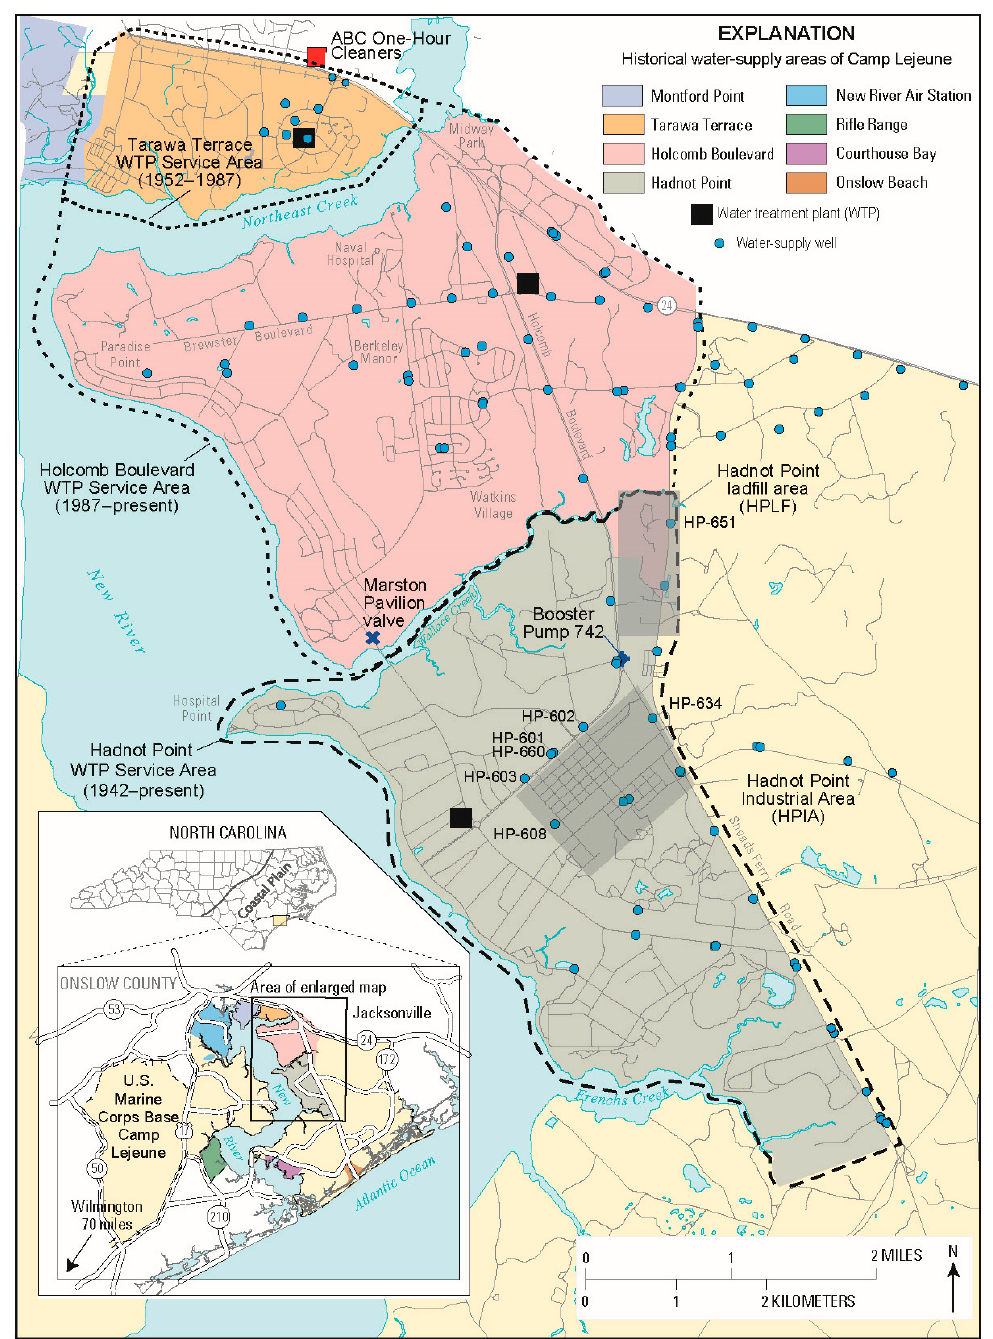
Figure 1. Water ‐ supply areas with focus on housing areas, barracks, and workplaces included in the Figure 1. Water-supply areas with focus on housing areas, barracks, and workplaces included in Agency for Toxic Substances and Disease Registry (ATSDR) drinking ‐ water exposure and health the Agency for Toxic Substances and Disease Registry (ATSDR) drinking-water exposure and studies, U.S. Marine Corps Base Camp Lejeune, North Carolina (modified from [1]; 1 mi = 1.61 km).